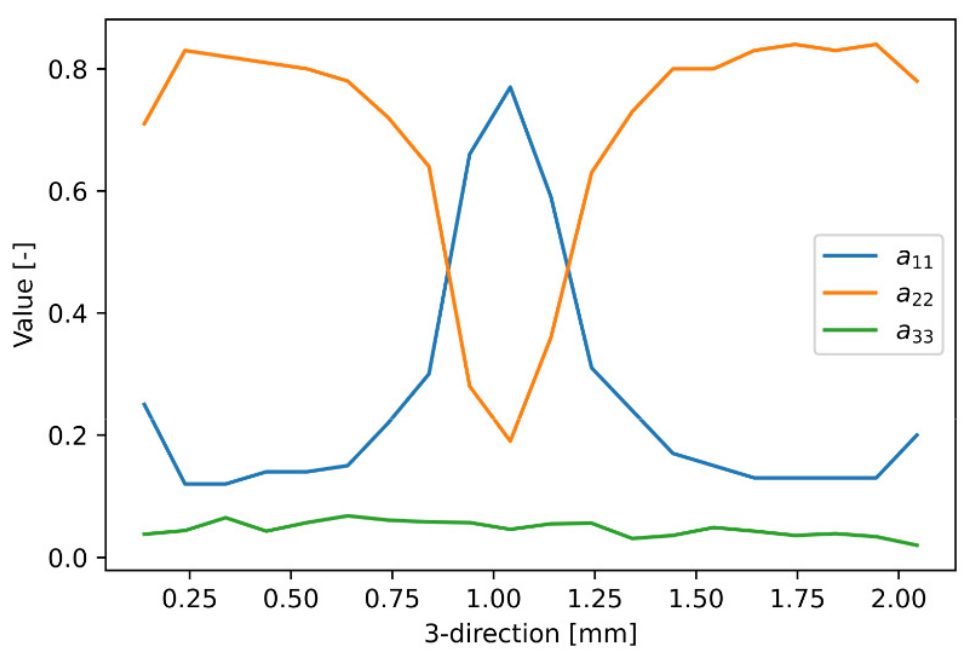
Figure 5. Measured components of fiber orientation tensor through thickness of the plates.